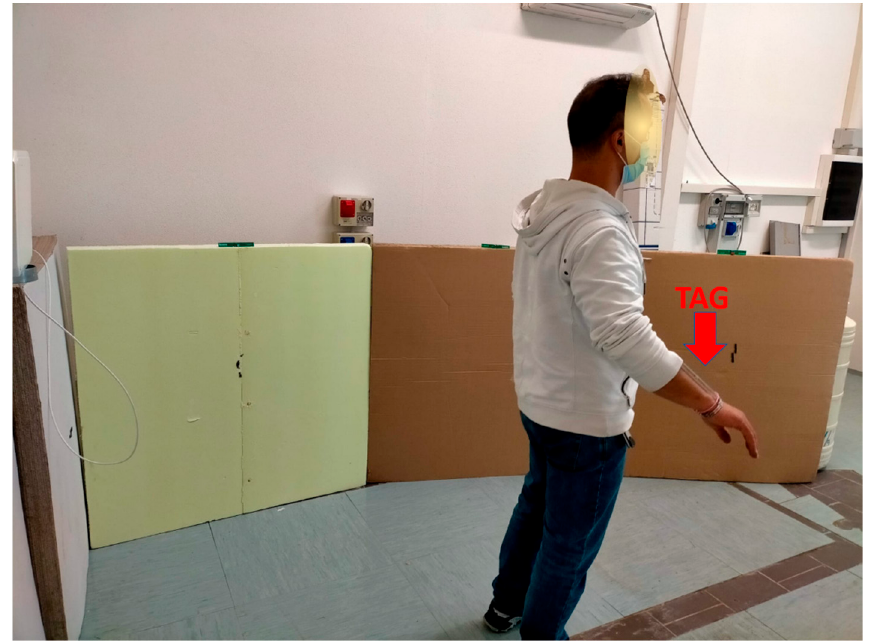
Figure 14. Example: operator moving in a room reproducing a real plant environment. Table 1. True and estimated distances as a function of the computed RSSI. True Distance [m] Algorithm Estimated Distance